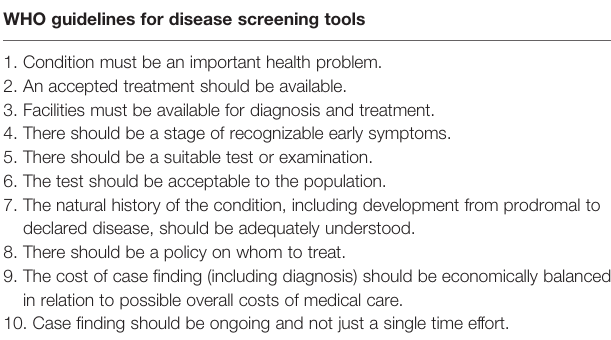
TABLE 1 | World Health Organization Guidelines, Abbreviated (22). WHO guidelines for disease screening